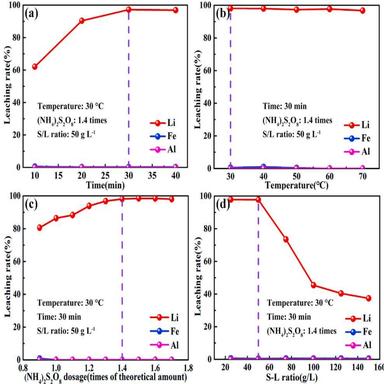
The effects on leaching efficiency of (a) reaction time at 30 ◦C, 1.4 times amount of theoretical (NH4)2S2O8 and S-L ratio of 50 g L− 1 , (b) reaction temperature at 30 min, 1.4 times amount of theoretical (NH4)2S2O8 and S-L ratio of 50 g L− 1 , (c) (NH4)2S2O8 dosage at 30 min, 30 ◦C and S-L ratio of 50 g L− 1 , (d) solid-liquid ratio at 30 min, 30 ◦C, 1.4 times amount of theoretical (NH4)2S2O8.